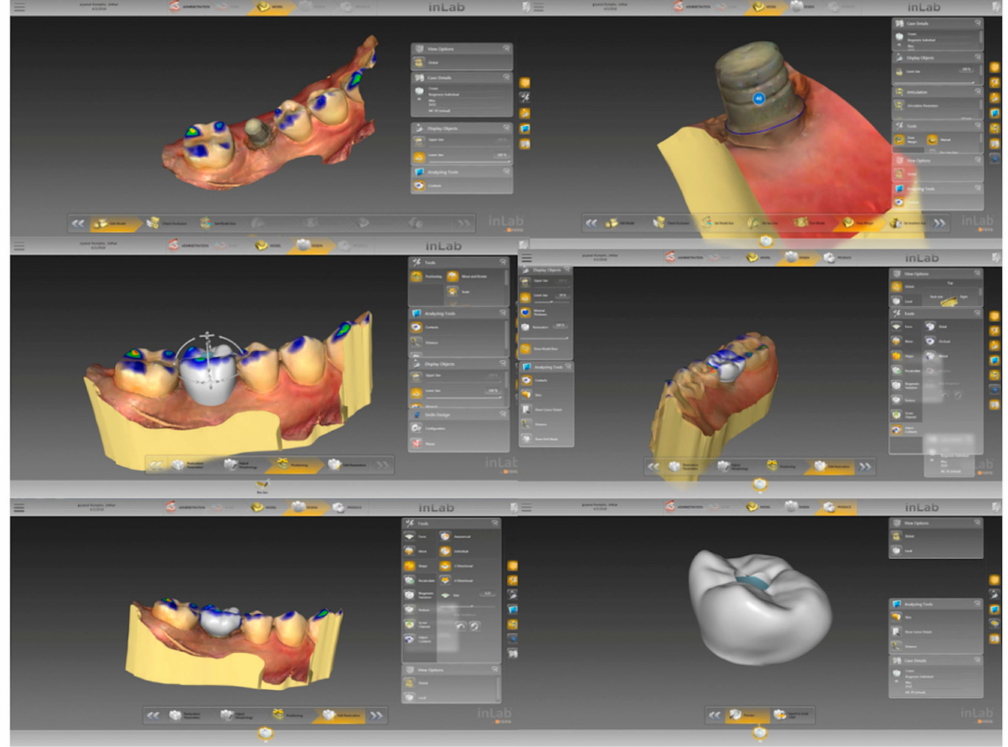
Figure 3. Screwed-retained crown was designed from Inlab SW programme and sent to milling machine (MCX5, Dentsply Sirona ® , York, PA,